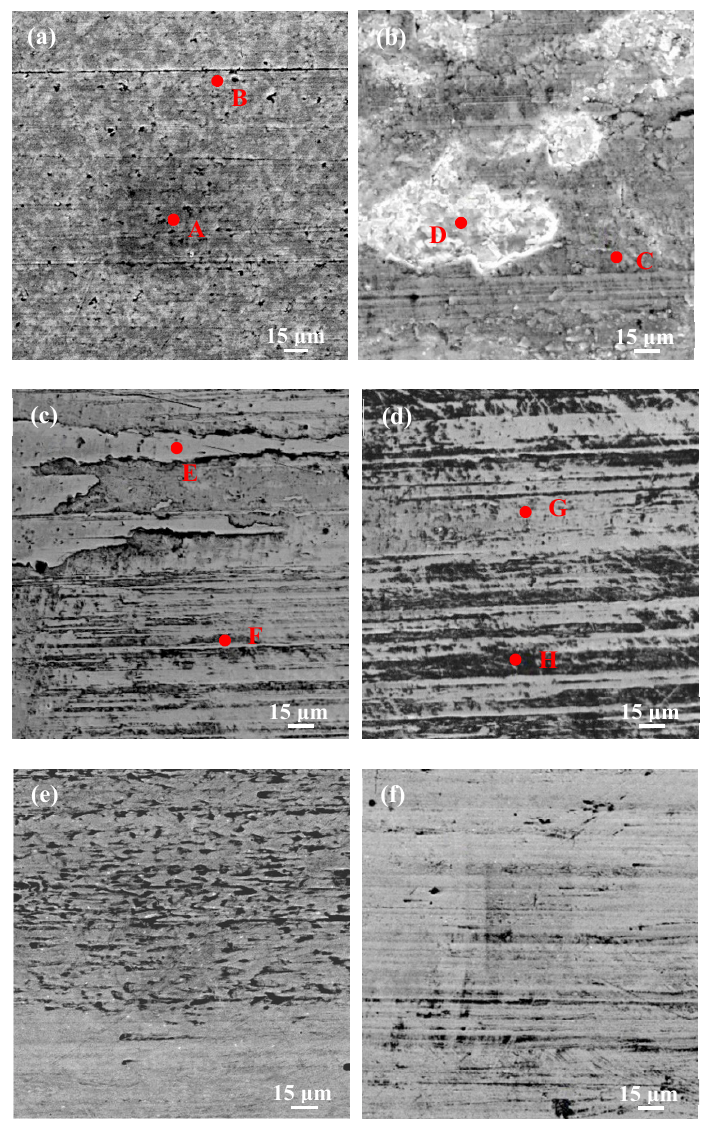
Figure 14. The morphologies of the worn surface of the composite coatings ( a ) 0 A; ( b ) 30 A; ( c ) 45 A; ( d ) 60 A; ( e ) 80 A; ( f ) 100 A (conditions: load 10 N, sliding speed 260 mm/s, sliding distance 90,000 mm).